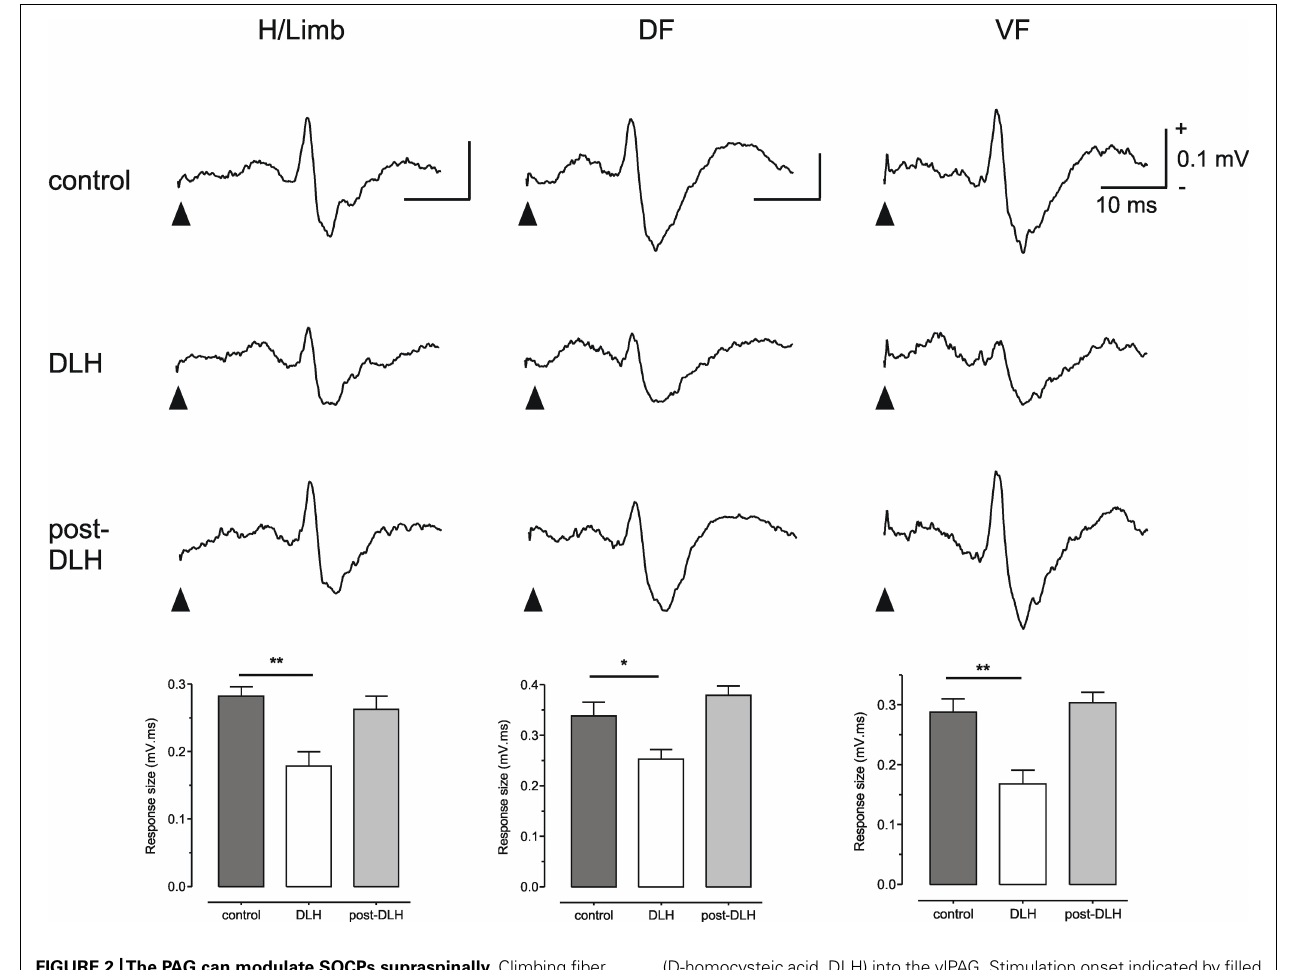
FIGURE 2 |The PAG can modulate SOCPs supraspinally. Climbing fiber fields evoked by stimulation of contralateral hindlimb (H/Limb), ipsilateral dorsal funiculus (DF) and contralateral ventral funiculus (VF) are all significantly suppressed following microinjection of an excitatory amino acid